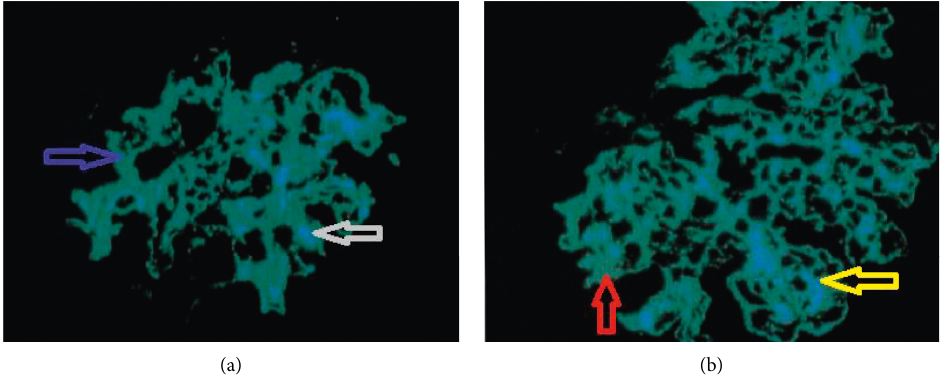
Figure 2: Image (a) showing immunofluorescence (IF) staining for immunoglobulin G 3 (IG3), green representing the signal for IG3 (blue arow), with the nuclei in blue pointed with the gray arow. Image (b) showing IF staining for lambda, green representing the signal (red arow), with the nuclei in blue pointed with the yellow